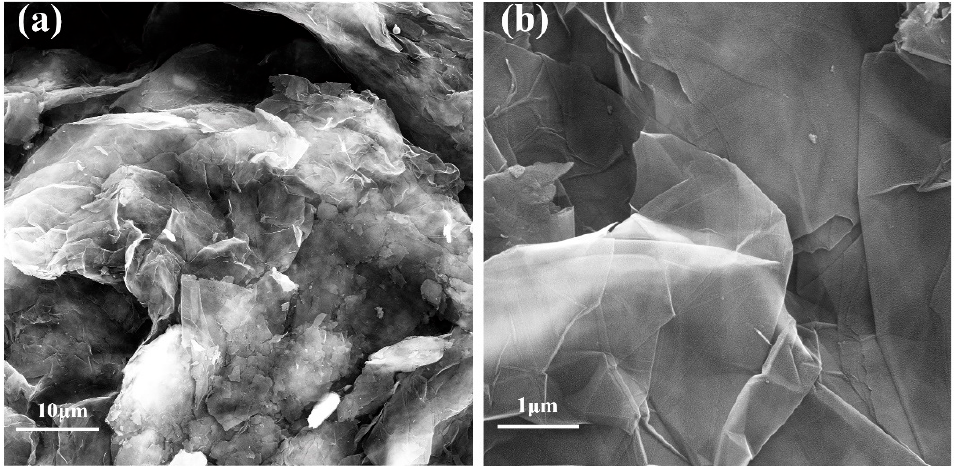
Figure 2. ( a ) Low-resolution and ( b ) high-resolution SEM image of commercial carbon paper.